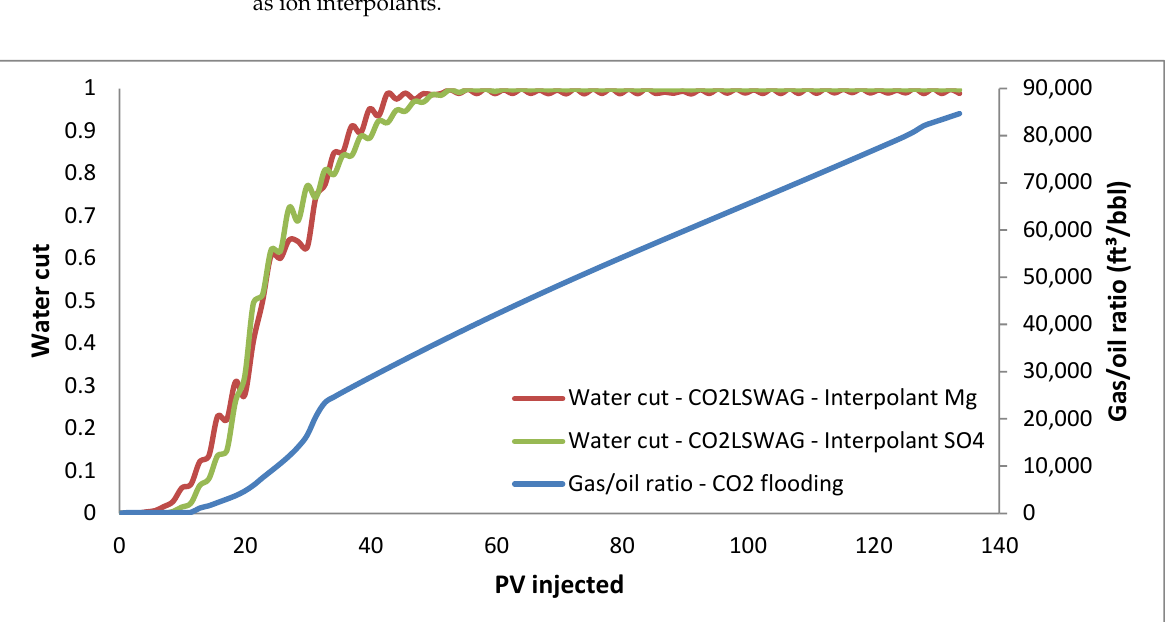
Figure 4. Average pressure for continuous CO 2 injection and CO 2 -LSWAG considering Mg and SO 4 as ion interpolants.